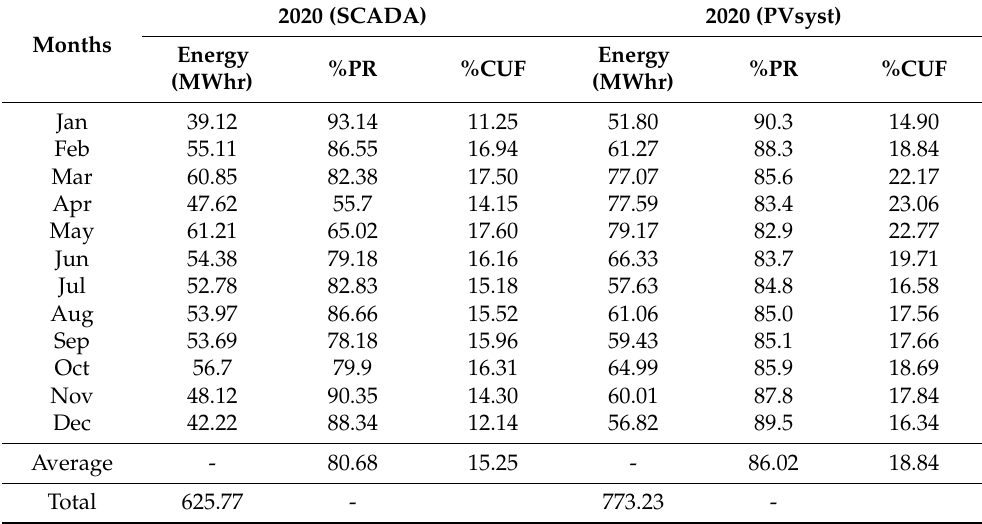
Table 9. Comparison of Generated Energy, %PR and %CUF in 2020 from 467.2 kWp Plant: SCADA (Recorded) vs. PVsyst .